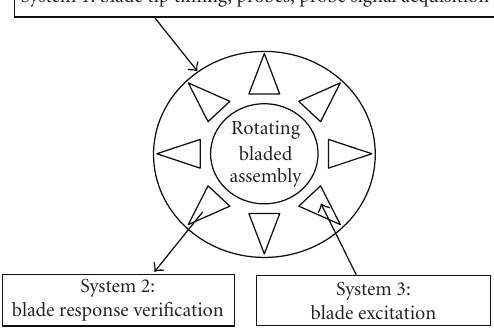
Figure 1: Conceptual design for BTT experimental rig.